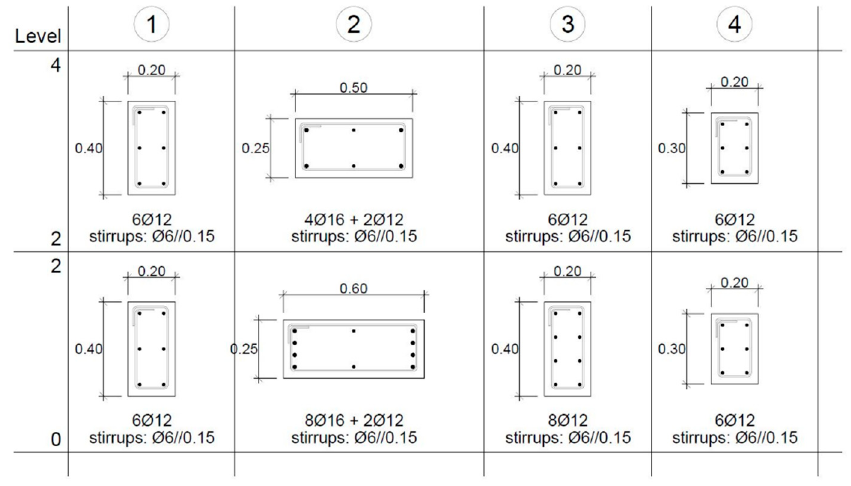
Figure 2. Column cross-section and reinforcement details (adapted from [8]).